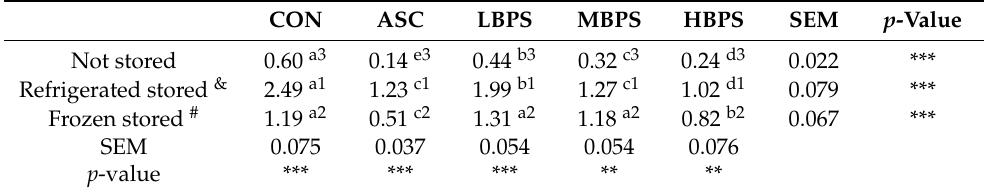
Table 4. Thiobarbituric acid reactive substances in recently cooked (not stored), refrigerated, and frozen stored patties (mg malondialdehyde/kg) as a function of the type and amount of antioxidant used ( n = 5). CON ASC LBPS MBPS HBPS SEM p -Value Not stored 0.60 a3 0.14 e3 0.44 b3 0.32 c3 0.24 d3 0.022 *** Refrigerated stored & 2.49 a1 1.23 c1 1.99 b1 1.19 a2 0.51